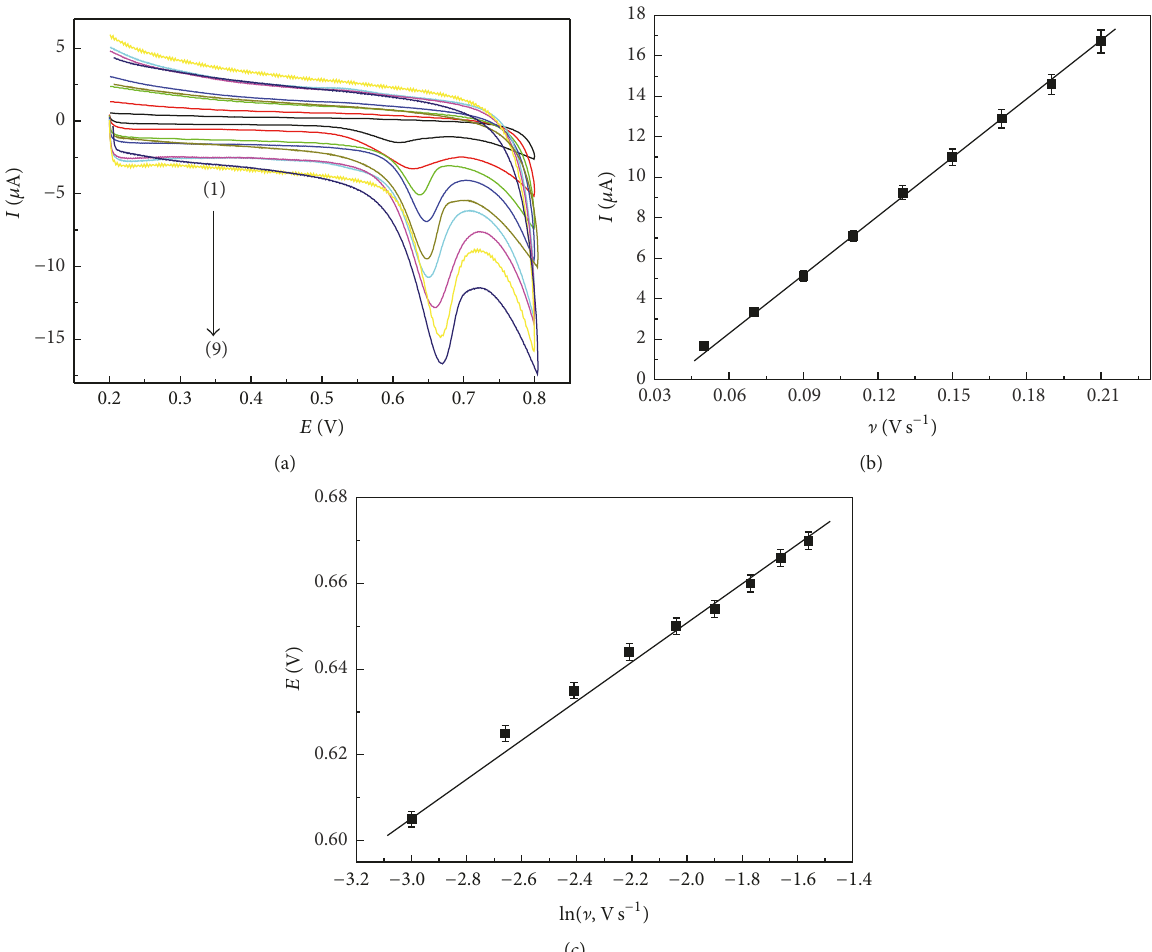
Figure 4: (a) CV curves of 20 𝜇 M trans -resveratrol in 0.04 M BR solution (pH 2.0) at the ERGO/GC electrode with different scan rate: (1) 50, (2) 70, (3) 90, (4) 110, (5) 130, (6) 150, (7) 170, (8) 190, and (9) 210mVs −1 . Effect of scan rate on oxidation peak current (b) and peak